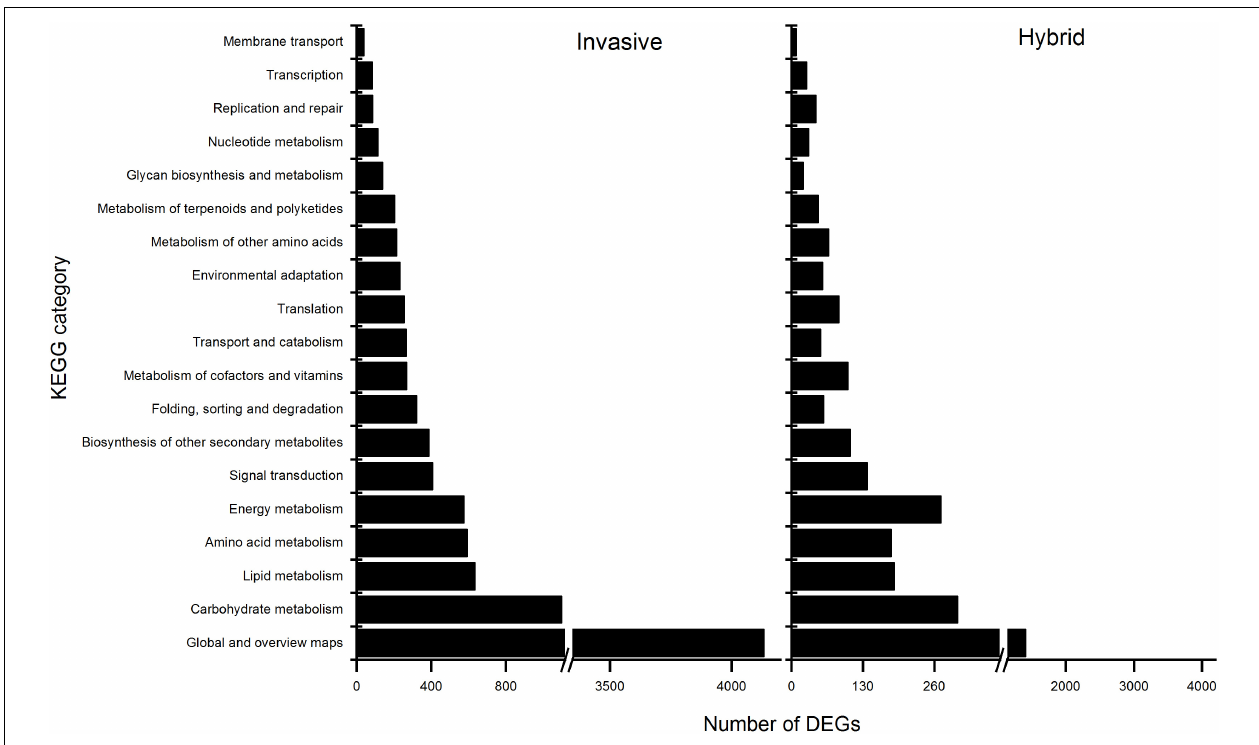
FIGURE 3 | Under Cd stress, KEGG annotation of DEGs in the leaves of invasive plants and hybrid.